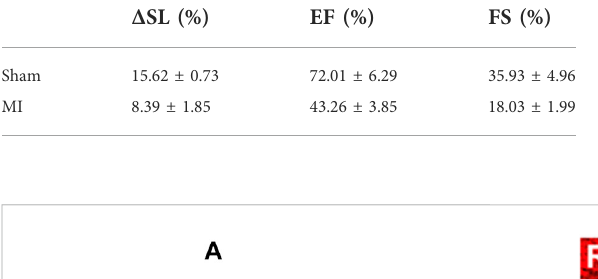
were able to measure the Δ SL in the cardiomyocytes of the control (sham) and MI mice. Figure 3 depicts the average distance between the sarcomeres at different time delays with respect to the peak of the R-wave, where a time delay with an increment of 30 ms was used to probe different phases in the cardiac cycles (Supplementary Figure S6C). In the sham model, the SL was shortened from ~2.11 to ~1.83 μ m (Figure 3A), which